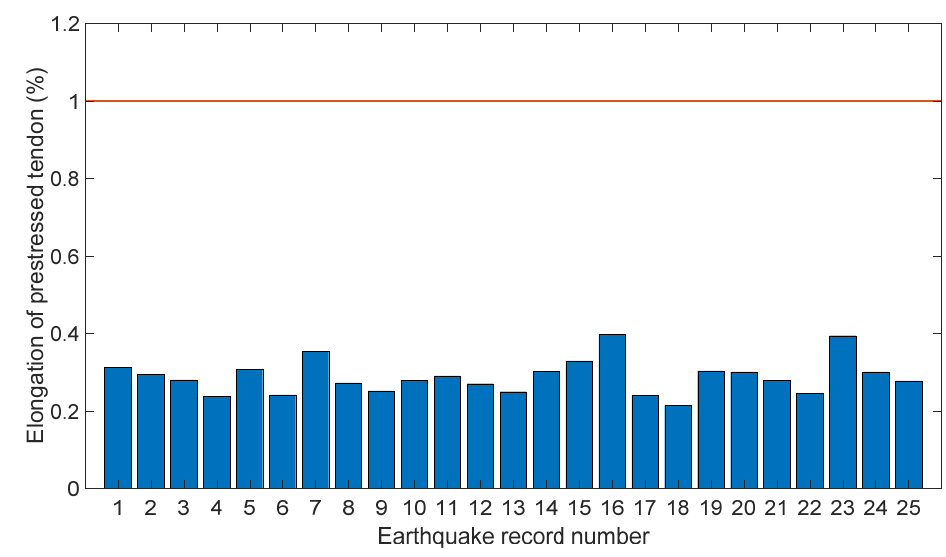
Figure 11. Maximum elongations of prestressed tendons.